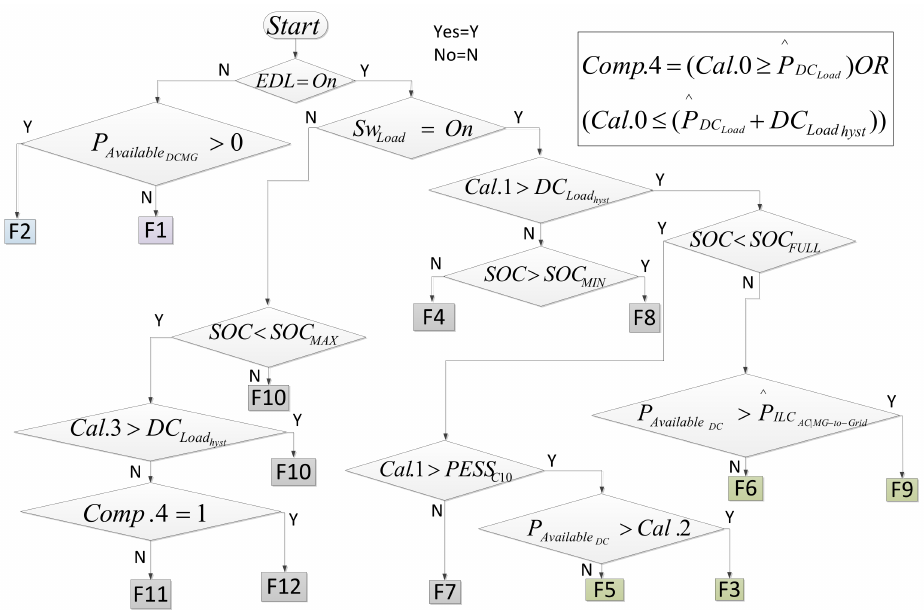
Figure 5. Power management algorithm of the